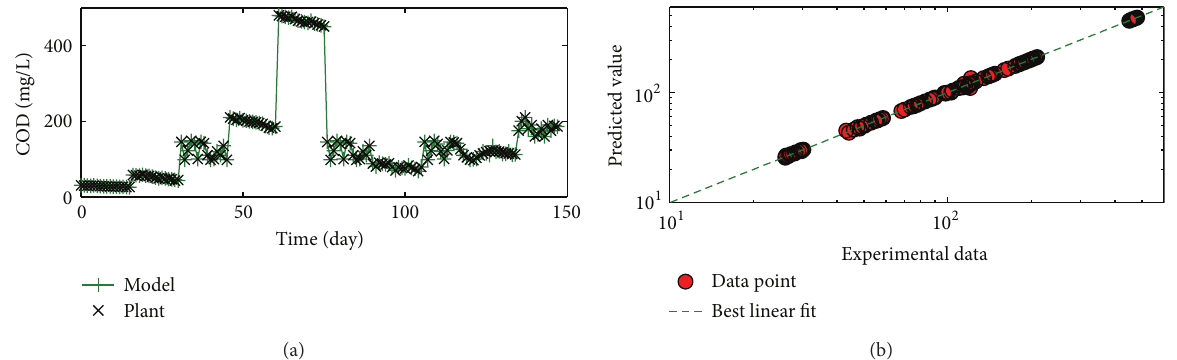
Figure 6: The responses of the developed model (a), Correlation between the actual values and the values predicted by the model for COD (b).